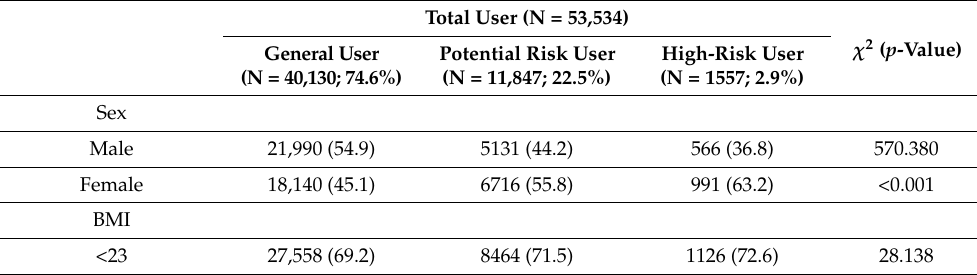
Table 1. General characteristics of the participants based on level of smartphone